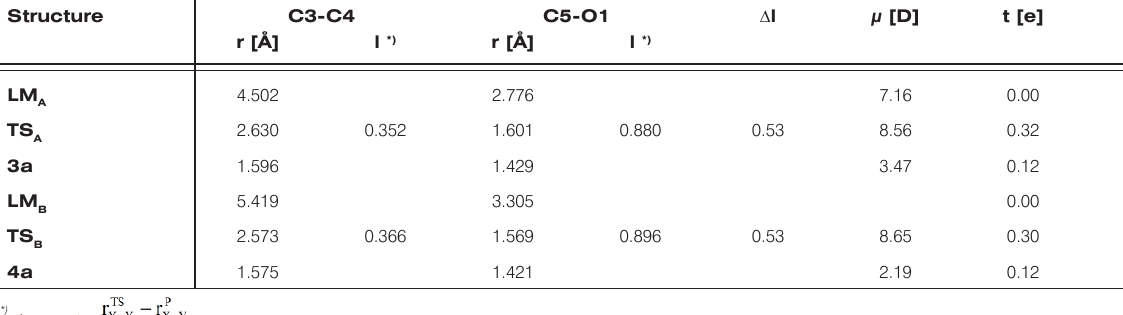
Table 3. Selected molecular properties of critical structures of [2+3] cycloaddition reaction between 1-chloro-1-nitroethene 1 and (Z)-C-(p-methoxyphenyl)-N-diphenylnitrone 2a according to B3LYP/6-31G(d) (PCM) calculations (298 K).